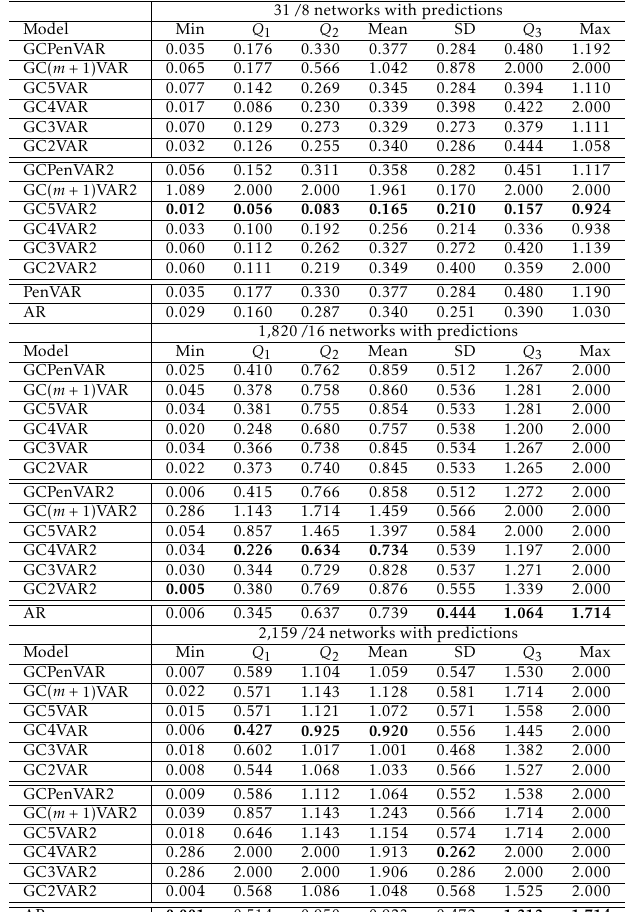
Table 4. Summary statistics of the SMAPE values of predictions by different models at / 8 , / 16 , and / 24 resolutions, where bold- font highlights the smallest SMAPE values or the most accurate predictions among all the models at a